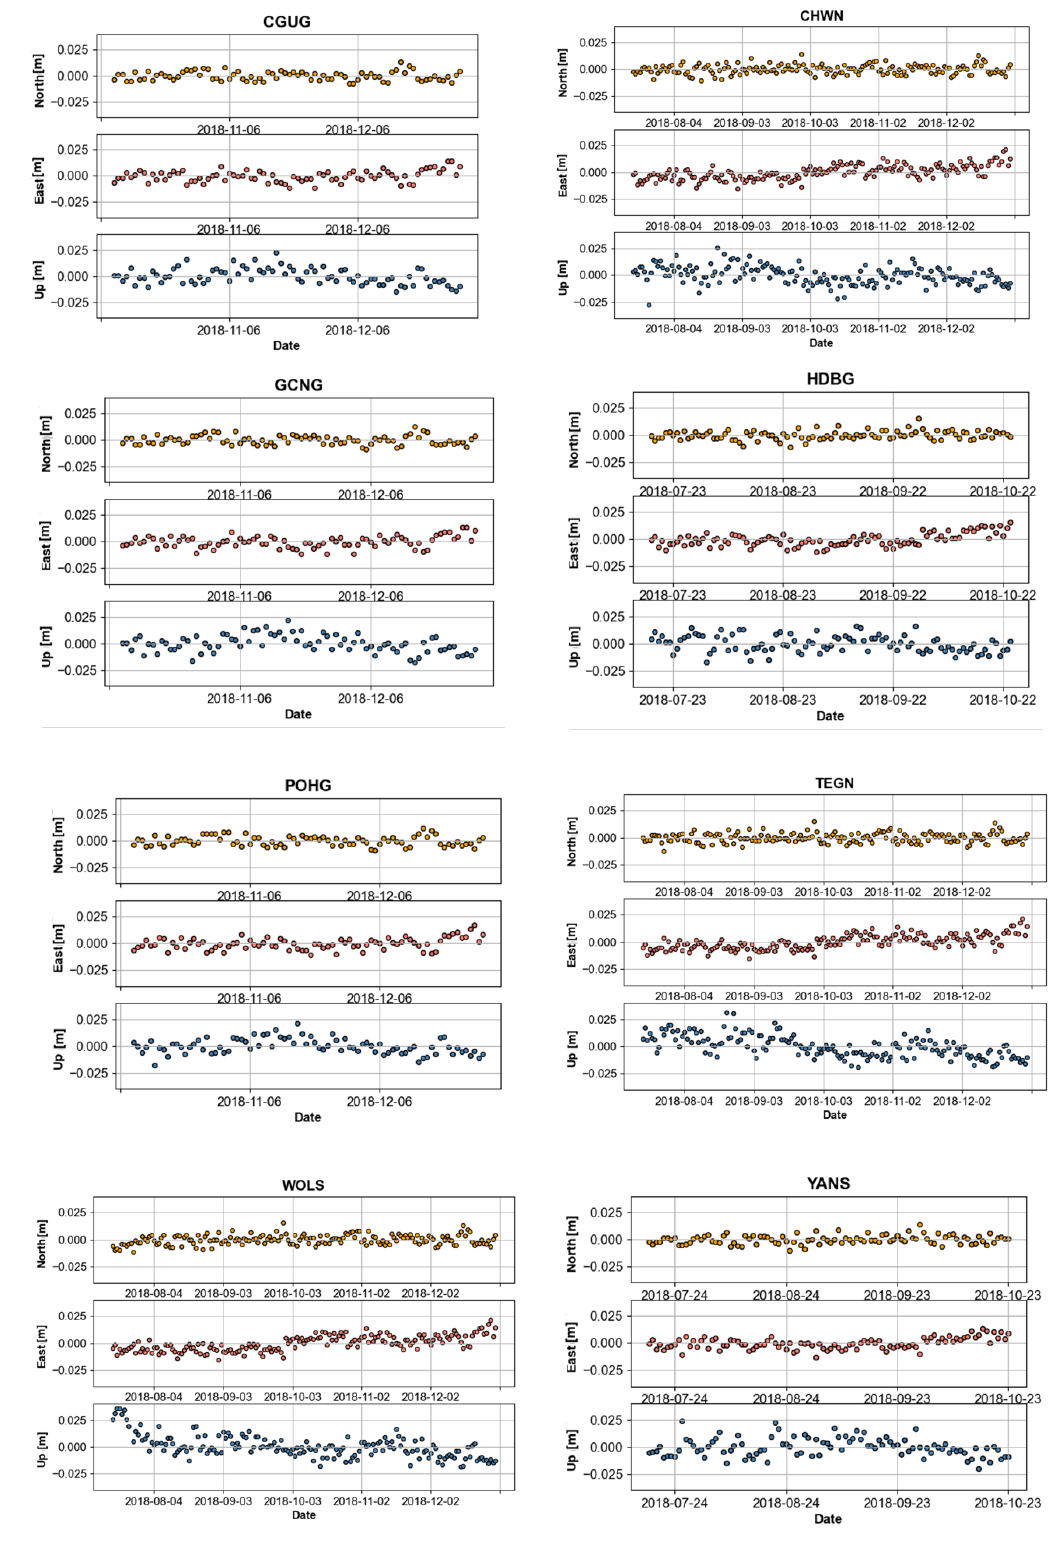
Figure A1. Time series GNSS Station in 2018.